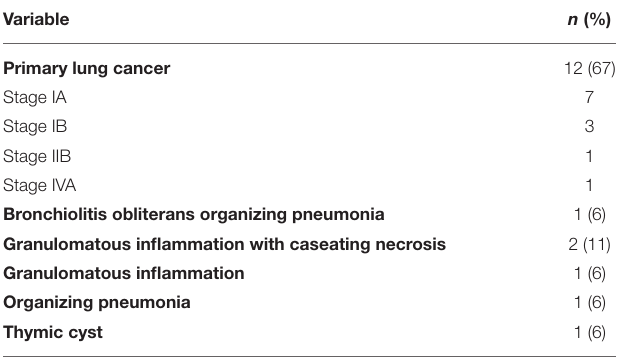
TABLE 4 | Pathological